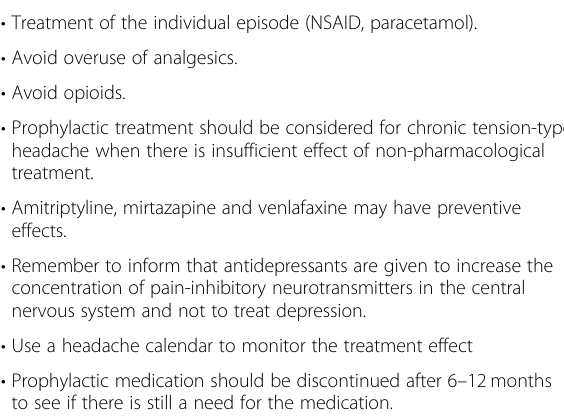
Non-pharmacological treatment of tension-type headache Pharmacological treatment of tension-type